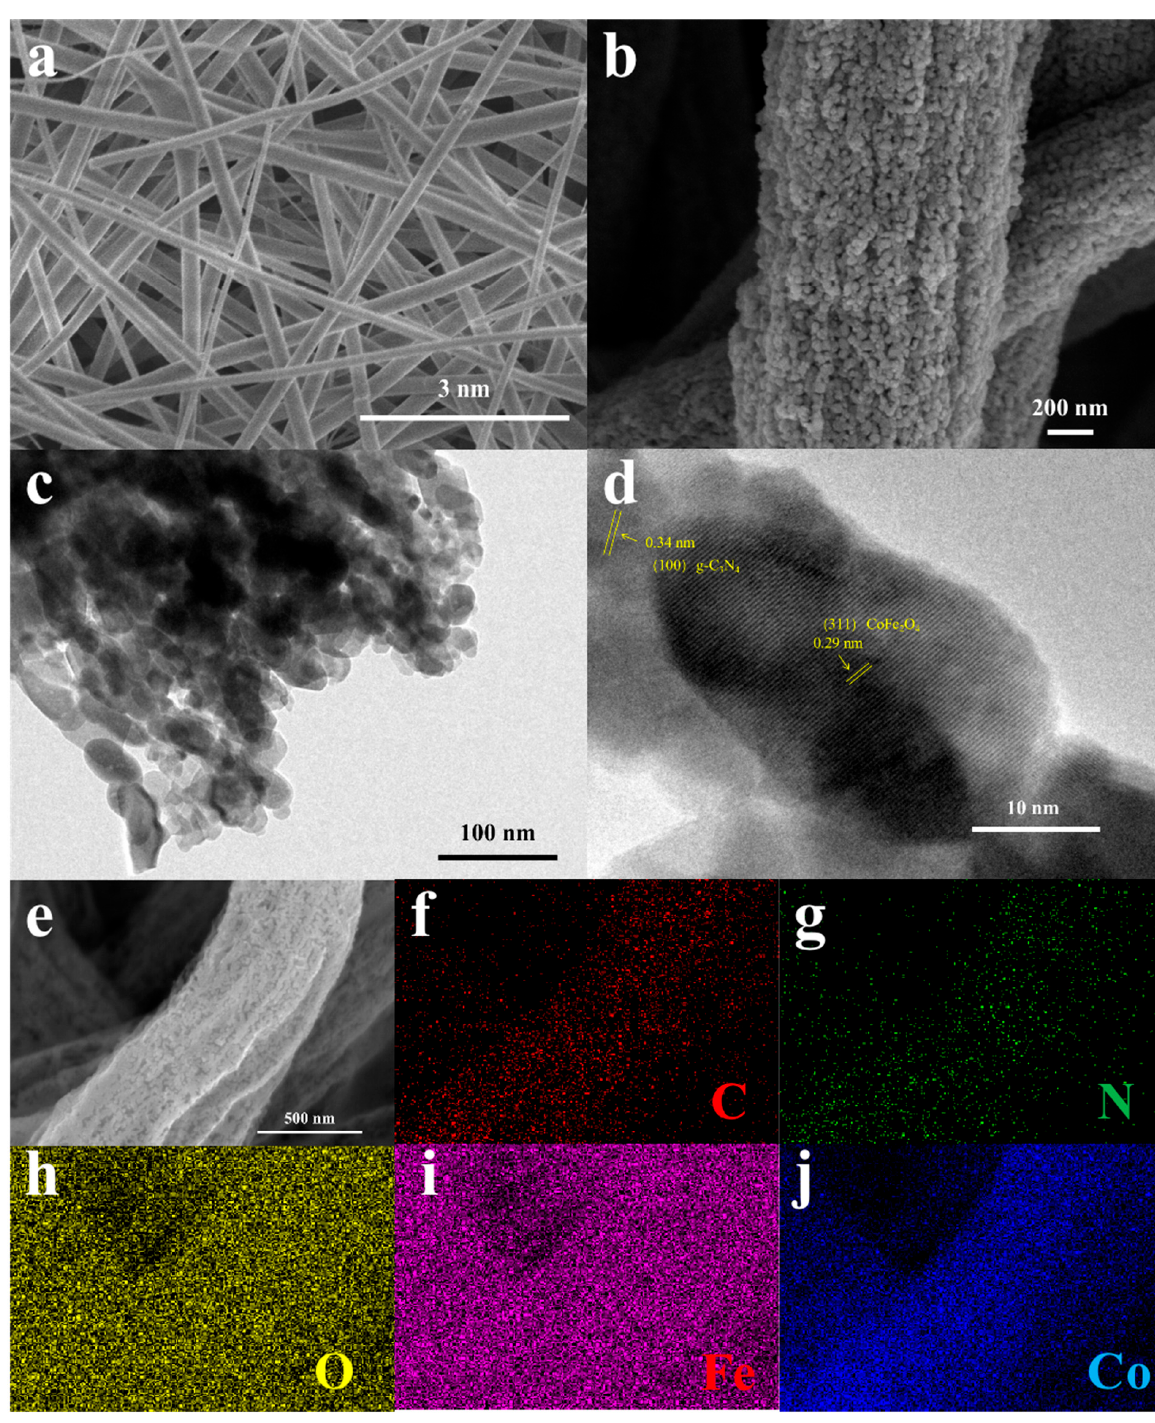
Figure 1. SEM images of CN/CFO-0.05 ( a , b , e ); TEM images of CN/CFO-0.05 ( c , d ); EDS elemental mapping images of CN/CFO-0.05 ( f – j ).